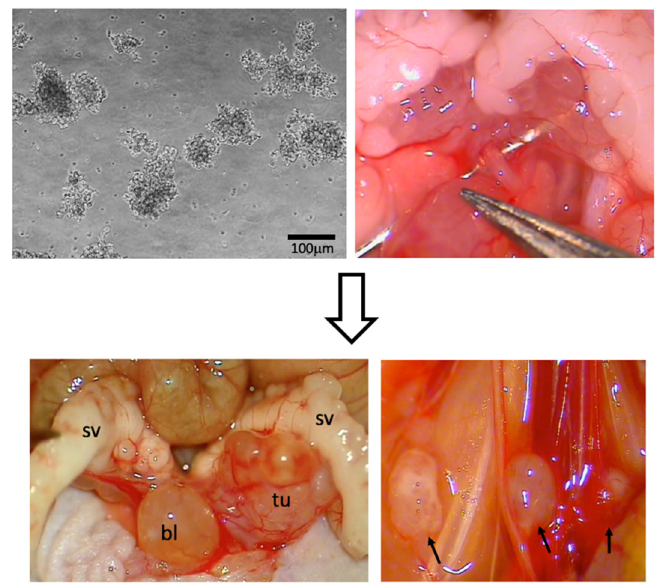
Figure 1. Orthotopic mouse model of oligometastatic prostate cancer. Injection of 3D LuCaP136 spheroids into the left anterior prostate lobe of CB17/lcr- Prkdc scid /lcrlcoCrl SCID mice (upper row) results in the development of a locally invasive, intraprostatic primary tumor and multiple lymph node metastases (lower row; metastases marked with arrows). bl = urinary bladder, sv = seminal vesicles, tu = tumor.